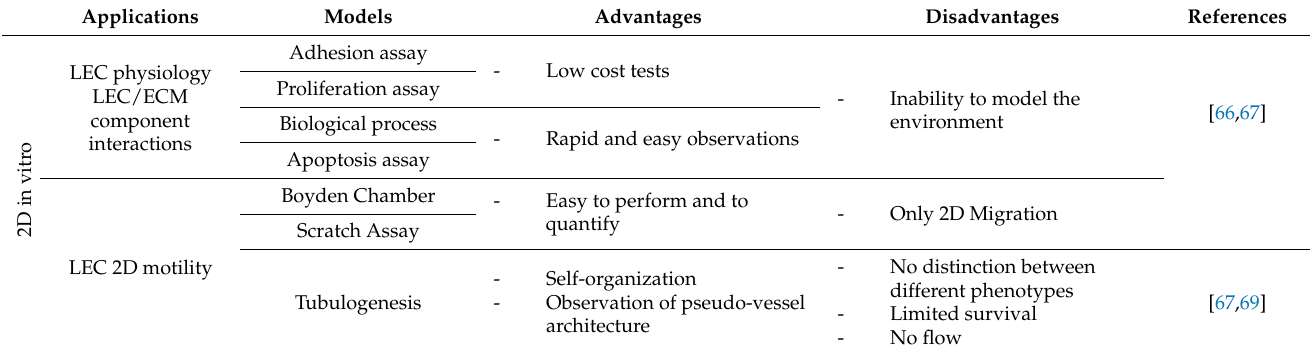
Table 1. Advantages and disadvantages of the different cited lymphangiogenesis in vitro and in vivo